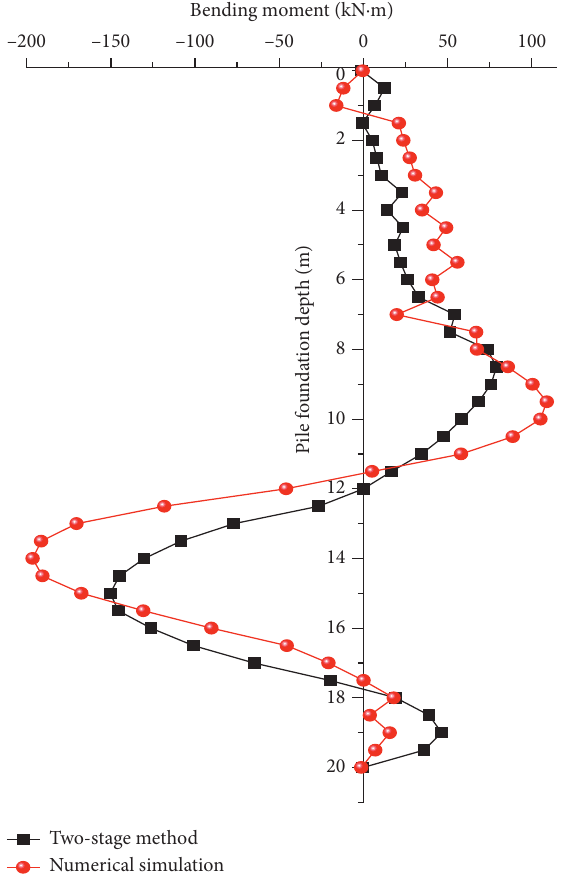
Figure 19: Bending moment of pile in clay. Table 3: Burgers parameters of saturated